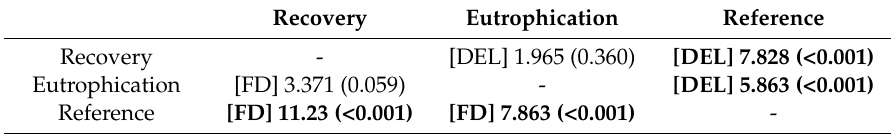
Table 3. Tukey’s pairwise comparisons (Q-value, p -values in brackets) of cladoceran functional diversity (FD) and mean Daphnia ephippia length (DEL) between periods of recovery (pre-1960), eutrophication (1960–1985), and recovery (post-1985). Statistically significant differences are marked in bold